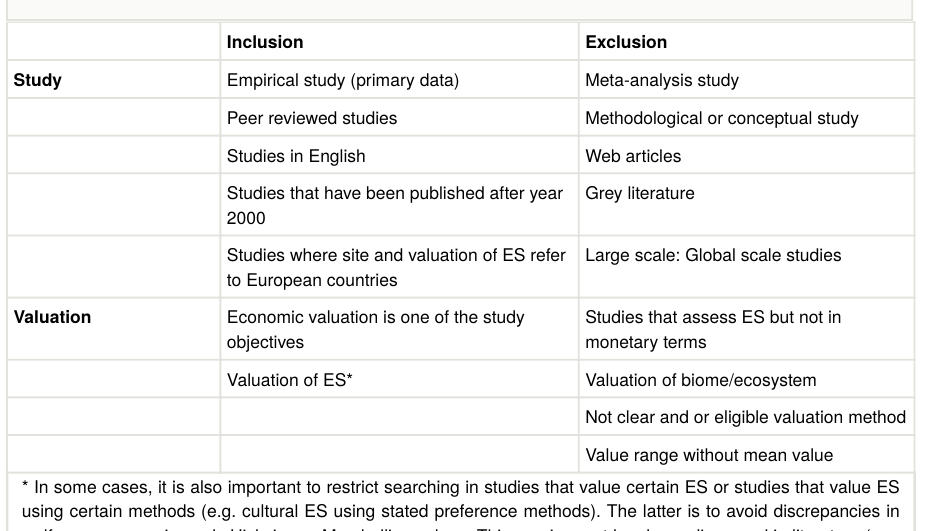
Eligibility criteria for inclusion of studies in systematic